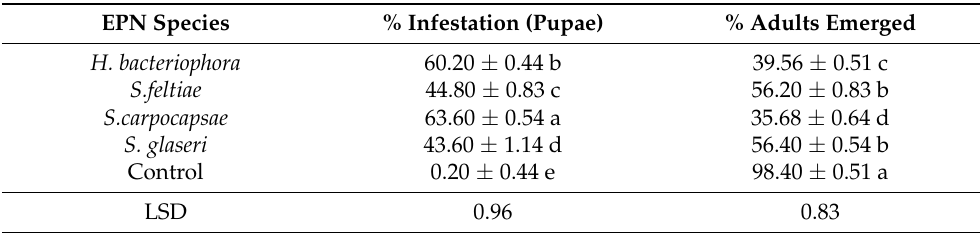
Table 2. Percent infestation and adult emergence based on treated pupae of red palm weevil.